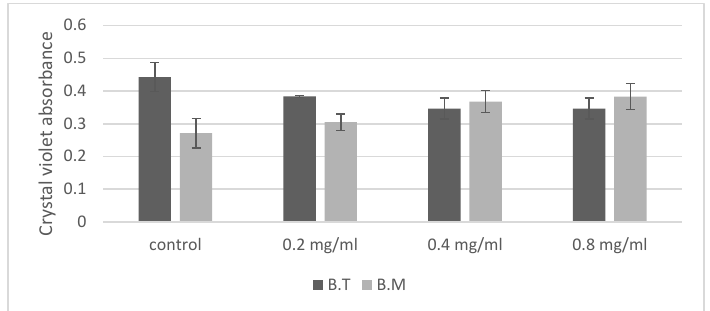
Figure 3. Effect of ZnO NPs on biofilm formation of Bacillus sp., expressed as crystal violet absorbance. The concentration of ZnO NPs statistically significantly affects the absorbance value of crystal violet, and the type of strain influences the absorbance of crystal violet in the presence of ZnO NPs. B.T.— Bacillus thuringiensis , B.M.— Bacillus megaterium